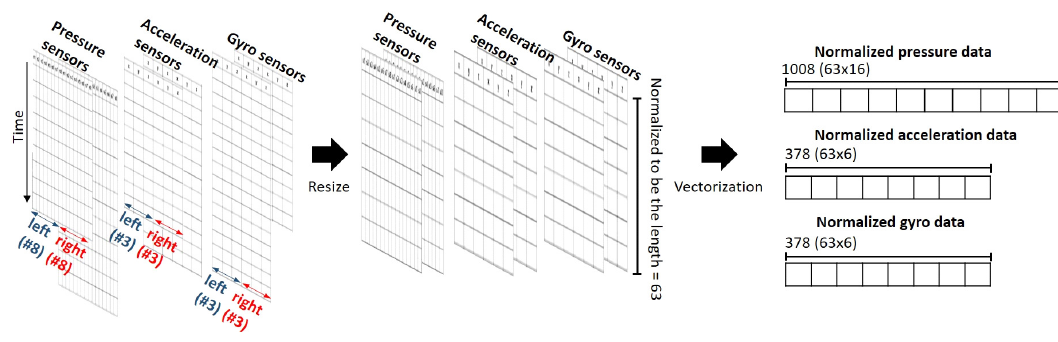
Figure 5. Raw data and the normalized data for the unit